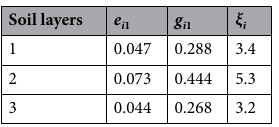
Table 5. Section 1 calculation parameters.